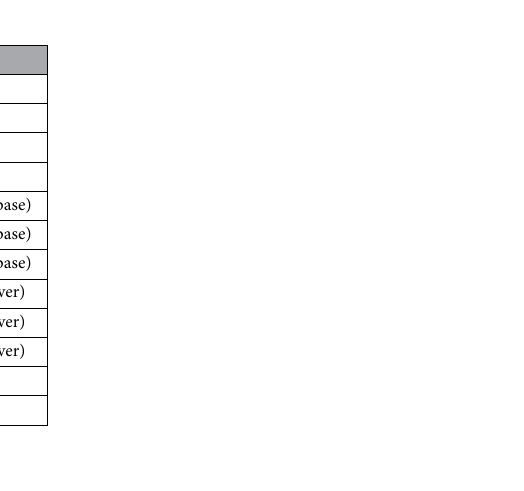
Figure 10. Study region division in California: ( a ) California Department of Forestry and Fire Protection (CAL FIRE) Administrative Units; ( b ) California climate divisions from National Oceanic and Atmospheric Administration (NOAA).